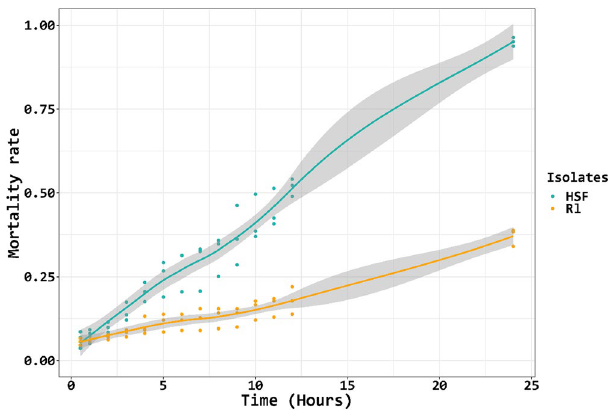
Figure 2. The mortality curves of A. besseyi Rl and HSF isolates after being treated with 500 ppm fenamiphos. The mortality rates were recorded at each hour for 12 h and the last data was taken at 24 h post-treatment. Grey bandsindicate the degree of